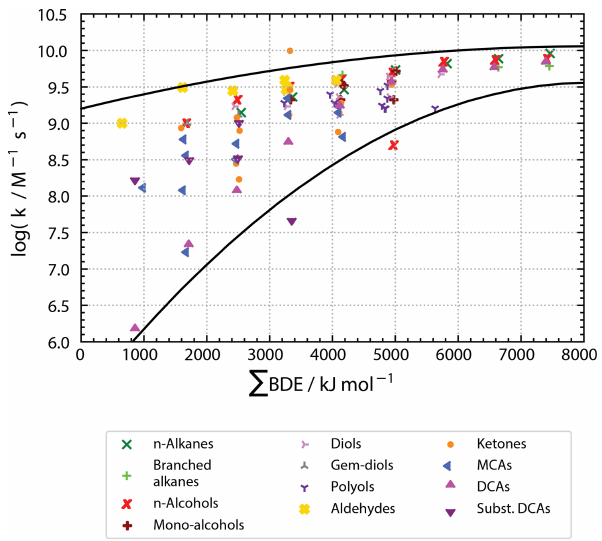
Figure 5. Plot of experimentally determined second-order rate con- stants versus accumulated bond strengths of all bonds containing hydrogen atoms in a molecule ( (cid:54) BDE) distinguished by compound classes. Black lines mark upper and lower boundary parabolas with most of the data lying within these boundaries.